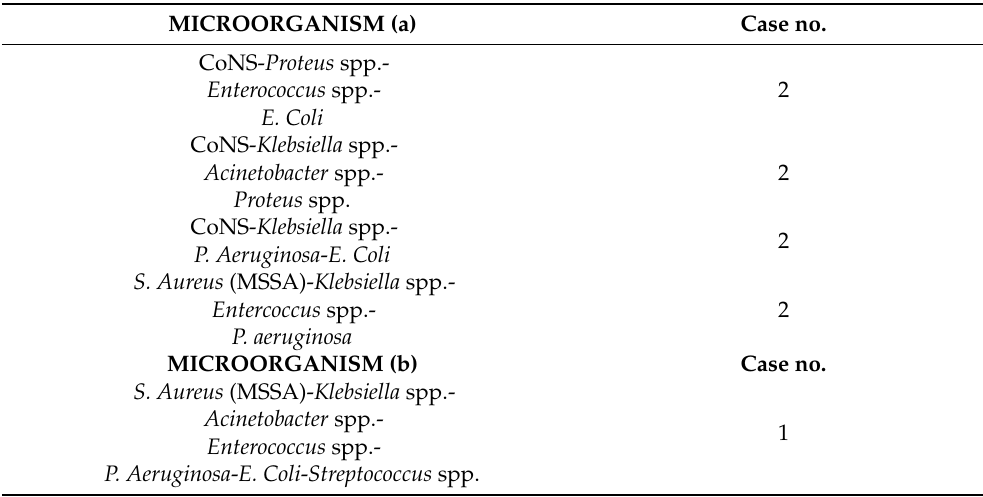
Table 6. Cont. MICROORGANISM CASE NO. Klebsiella spp.- Acinetobacter spp. 19 CoNS- P. aeruginosa 18 Klebsiella spp.- Enterococcus spp. 17 CoNS- E. coli 15 CoNS- Acinetobacter spp. 12 Staphylococcus spp.- Enterococcus spp. 12 Klebsiella spp.- Proteus spp. 12 CoNS- Proteus spp. CoNS- Staphylococcus spp. Klebsiella spp.- P. aeruginosa Proteus spp.- E. coli Table 7. Frequently identified tri-microbial associations. MICROORGANISM CASE NO. S. aureus (MSSA)- Klebsiella spp.- Enterococcus spp. 7 CoNS- Klebsiella spp.- Acinetobacter spp. 5 Klebsiella spp.- Acinetobacter spp.- E. Coli 5 CoNS- S. aureus (MSSA)- Enterococcus spp. 4 CoNS- Klebsiella spp.- Proteus spp. 4 CoNS- Klebsiella spp.- E. Coli 4 CoNS- Proteus spp.- Enterococcus spp. 4 CoNS- Enterococcus spp.- P. Aeruginosa 4 Klebsiella spp.- Acinetobacter spp.- P. Aeruginosa 4 Klebsiella spp.- Acinetobacter spp.- Proteus spp. 4 Klebsiella spp.- Proteus spp.- E. coli 4 CoNS- Klebsiella spp.- Enterococcus spp. 3 CoNS- Enterococcus spp.- E. Coli 3 CoNS- P. Aeruginosa - E. Coli 3 S. aureus (MSSA)- Klebsiella spp.- Acinetobacter spp. 3 Staphylococcus spp.- Klebsiella spp.- Enterococcus spp. 3 Klebsiella spp.- Enterococcus spp.- E. Coli 3 Klebsiella spp.- Enterococcus spp.- P. Aeruginosa Klebsiella spp.- P. Aeruginosa - E. Coli Table 8. Frequently identified quadri- (a) and hepta-microbial (b) associations. MICROORGANISM (a) Case no. CoNS- Proteus spp.- Enterococcus spp.- E. Coli CoNS- Klebsiella spp.- Acinetobacter spp.- Proteus spp. CoNS- Klebsiella spp.- P. Aeruginosa - E. Coli S. Aureus (MSSA)- Klebsiella spp.- Entercoccus spp.- P. aeruginosa MICROORGANISM (b) Case no. S. Aureus (MSSA)- Klebsiella spp.- Acinetobacter spp.- Enterococcus